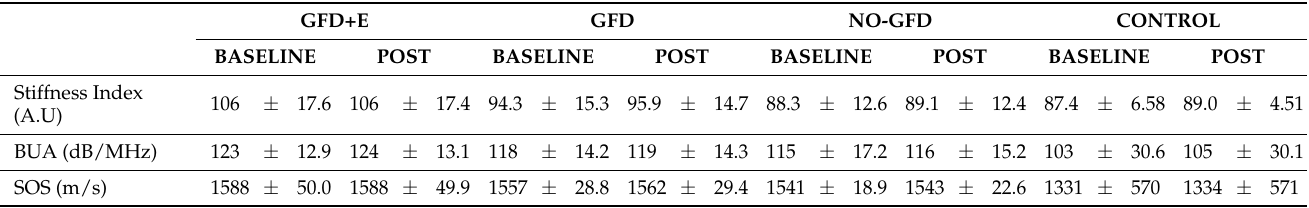
Table 1. Descriptive data on bone